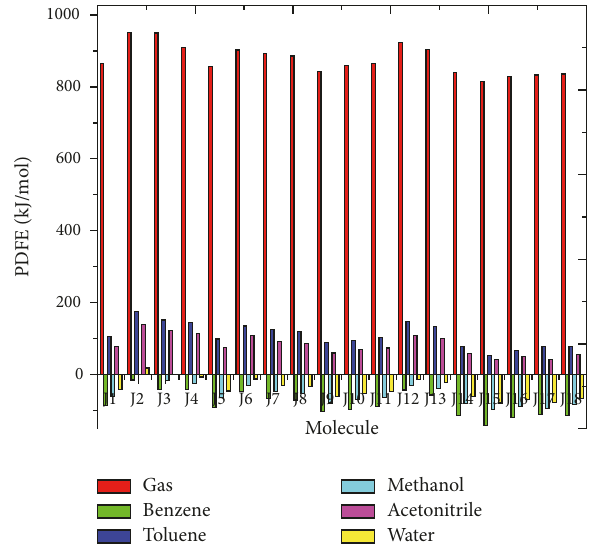
Figure 6: Proton dissociation free energies of J 𝑛 (in kJ/mol) at B3LYP/6-31+G(d,p) level in various